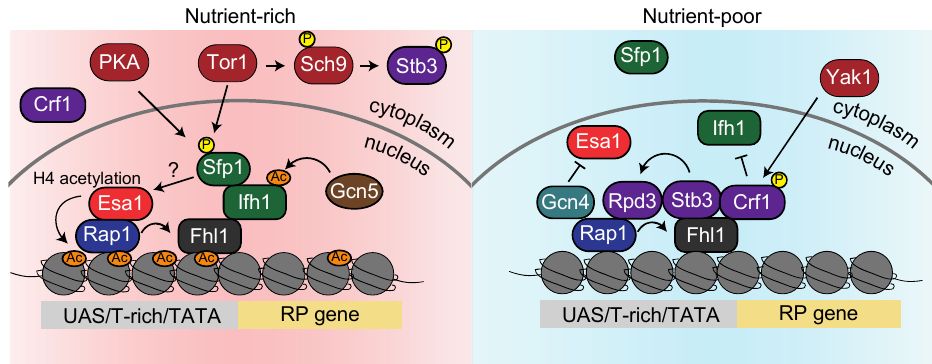
Figure 4. Regulatory mechanisms of RP gene expression in S. cerevisiae . In nutrient-rich environments (the pink area on the left), histone acetyltransferase Esa1 is recruited to the promoter of RP genes via interaction with Rap1. Ifh1 and Sfp1, which are recruited via the Fhl1 scaffold, also contribute to the expression of RP genes. In addition, the repressor Stb3 is phosphorylated by Sch9, which acts downstream of TORC1 (Tor1), preventing its accumulation at RP gene promoters. In nutrient-poor environments (the blue area on the right), Gcn4, interacting with Rap1, prevents the recruitment of Esa1 to RP genes. Moreover, Ifh1 and Sfp1 are dissociated from Fhl1, and the repressors Crf1 and Stb3 are recruited instead, leading to the accumulation of